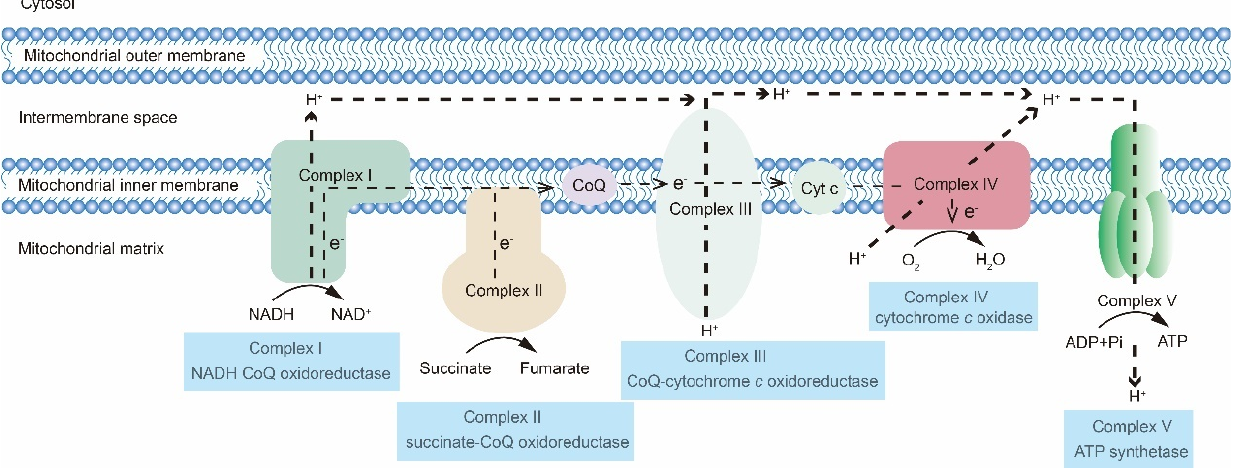
Figure 1. Mitochondrial OXPHOS system. Electrons are transferred via NADH to Complex I and then transported to CoQ. Flavin-containing enzyme complexes can directly deliver electrons to CoQ. CoQ transfers electrons to Complex IV through Complex III and Cyt c. In this step, oxygen is reduced to water. Complexes I, III, and IV pump H + from the mitochondrial matrix into the intermembrane space, which generates a proton gradient. Eventually, Complex V leverages this proton gradient to produce ATP.